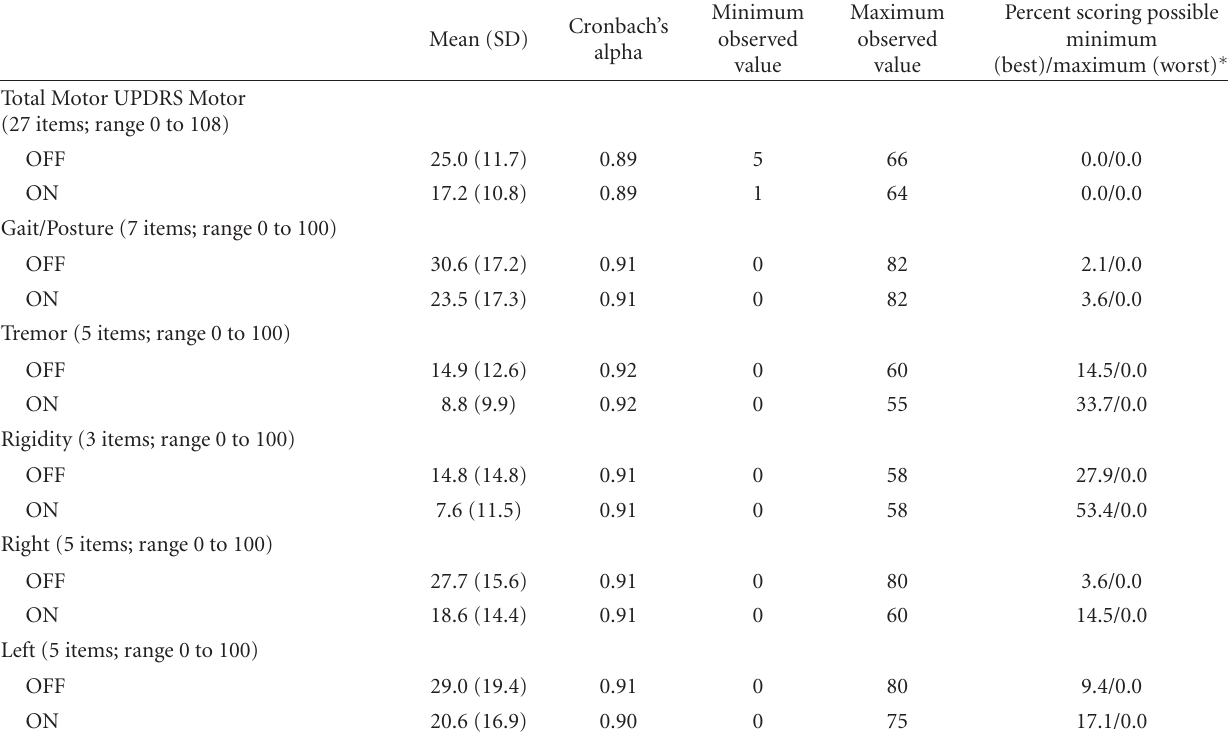
Table 3: Descriptive statistics for UPDRS motor score and subscales ( n = 193) ∗ . Mean (SD) value